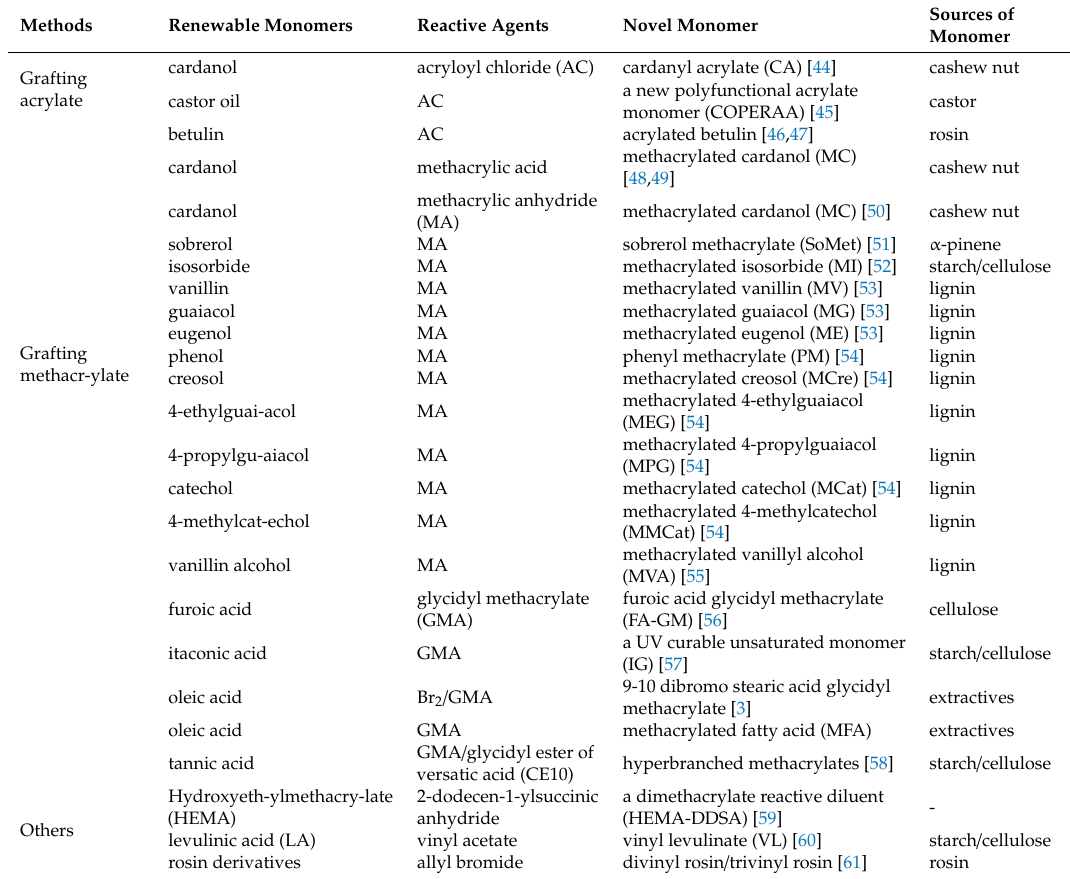
Table 3. Synthesis of novel monomers from renewable